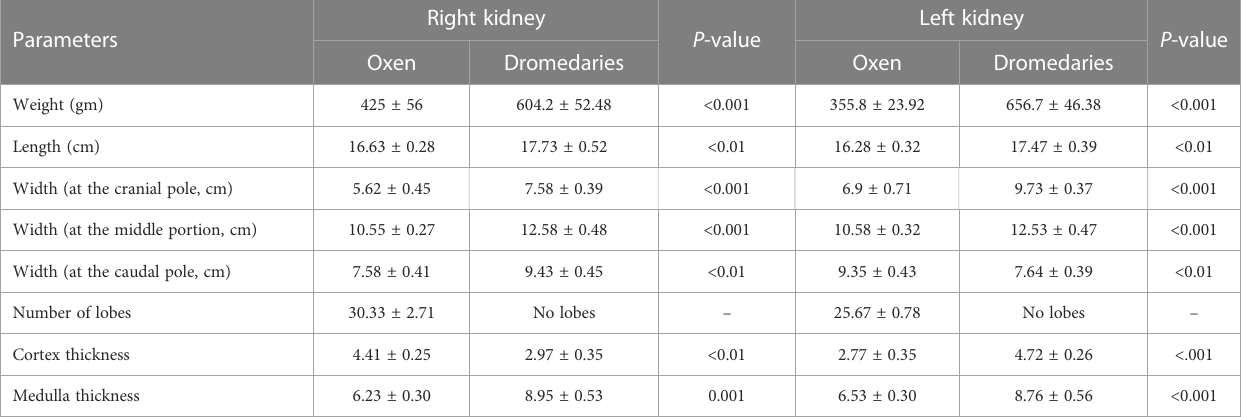
TABLE 2 Biometrical characteristics of the left and right kidneys in the oxen (n=20) and dromedaries (n=20).